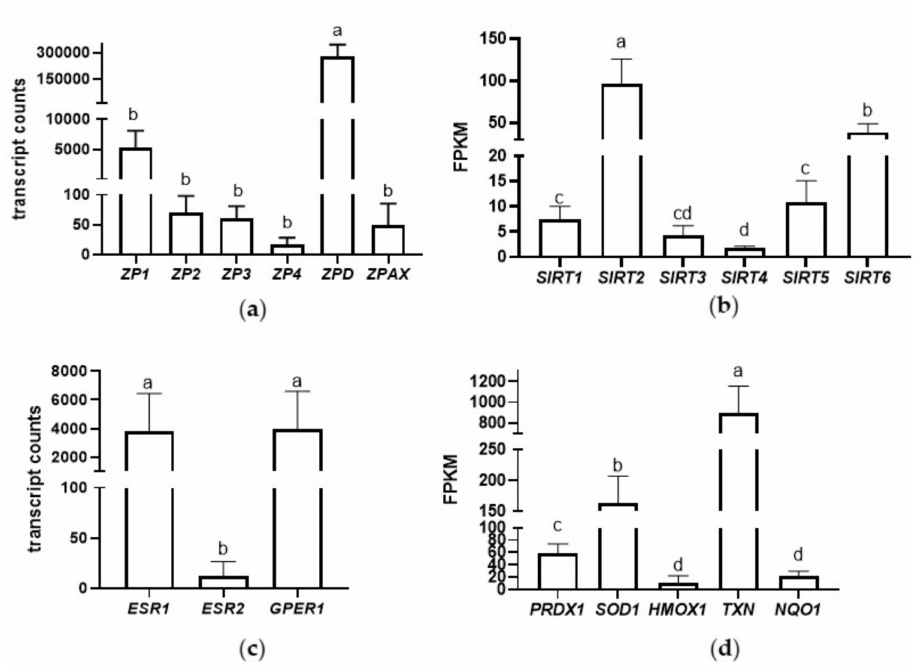
Figure 4. Transcripts identified in the inner perivitelline layer by RNA-Seq. Data are expressed as the mean ± SD. ( a ) Expression of six zona pellucida glycoprotein transcripts (ZP1, ZP2, ZP3, ZP4, ZPD, and ZPAX); ( b ) Expression of six sirtuin transcripts (SIRT1–6); ( c ) Expression of three transcripts involved in estrogen receptor signaling (ESR1, ESR2, and GPER1); and ( d ) Expression of five transcripts involved in the NRF2-mediated oxidative stress response (PRDX1, SOD1, TXN, heme oxygenase (HMOX1), and NAD(P)H quinone dehydrogenase 1 (NQO1)). Different letters indicate statistical significance at P ≤